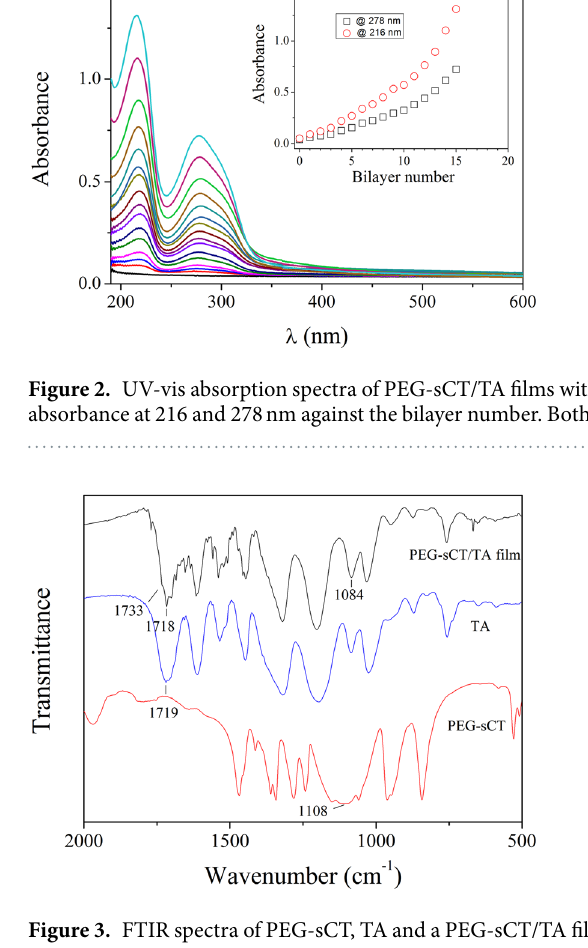
Figure 3. FTIR spectra of PEG-sCT, TA and a PEG-sCT/TA